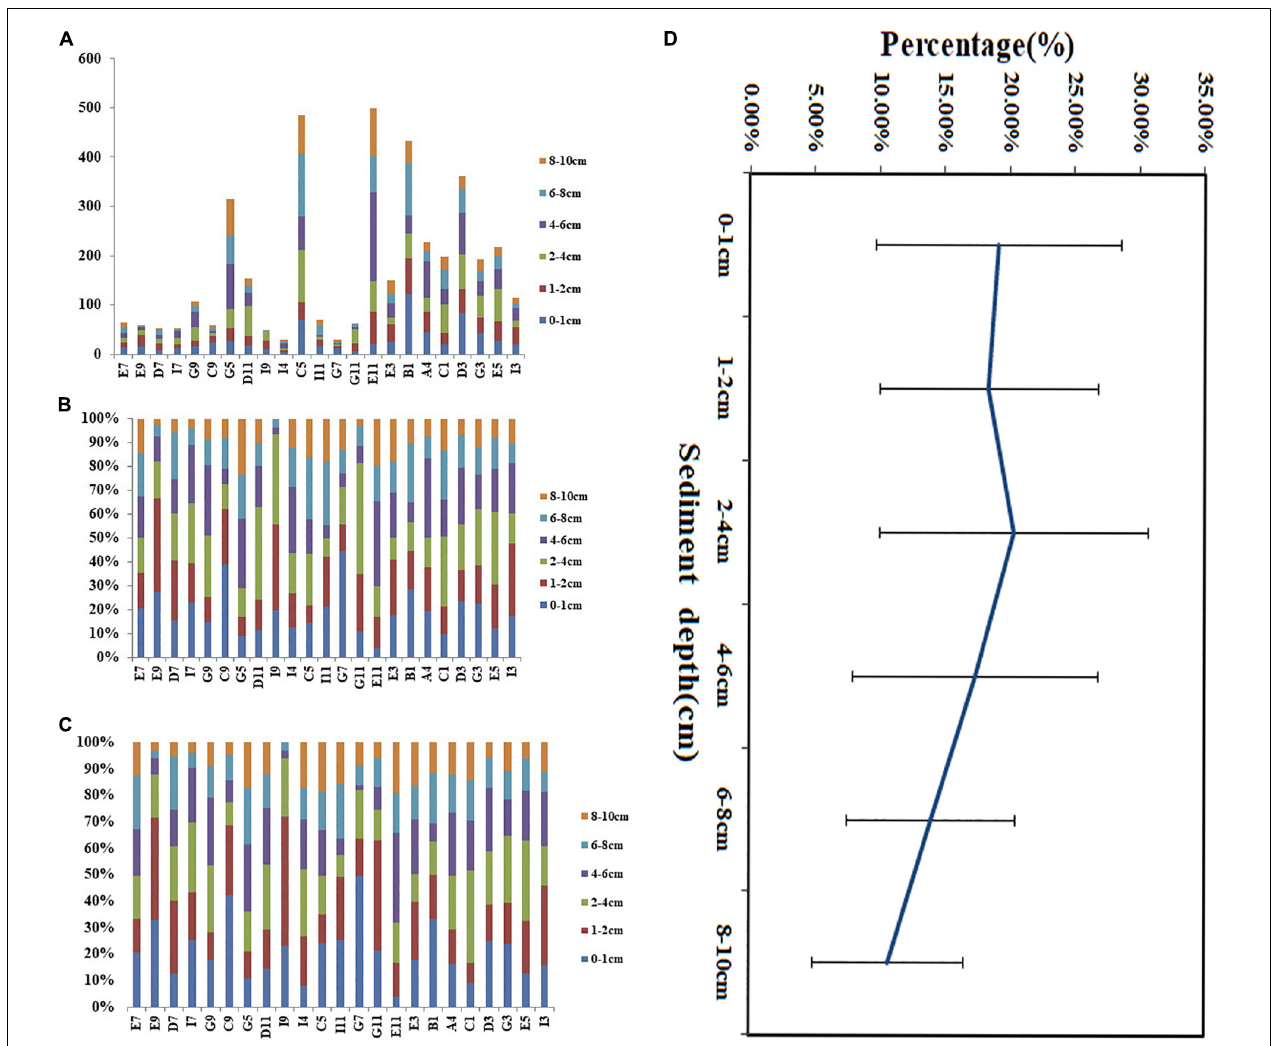
FIGURE 4 | Vertical distribution of meiofaunal abundance (A) , percentage of meiofauna (B,D) , and nematodes (C) at each sampling site in the adjacent areas of the Yap Trench, Western Pacific Ocean.